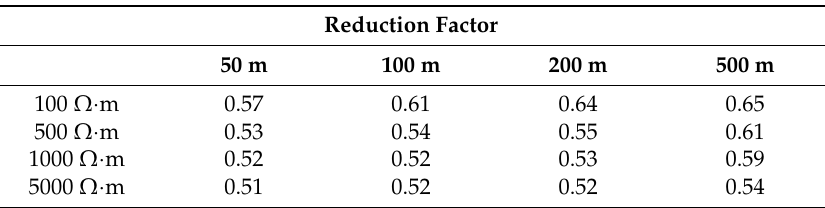
Table 4. Reduction factor of the metal shields.